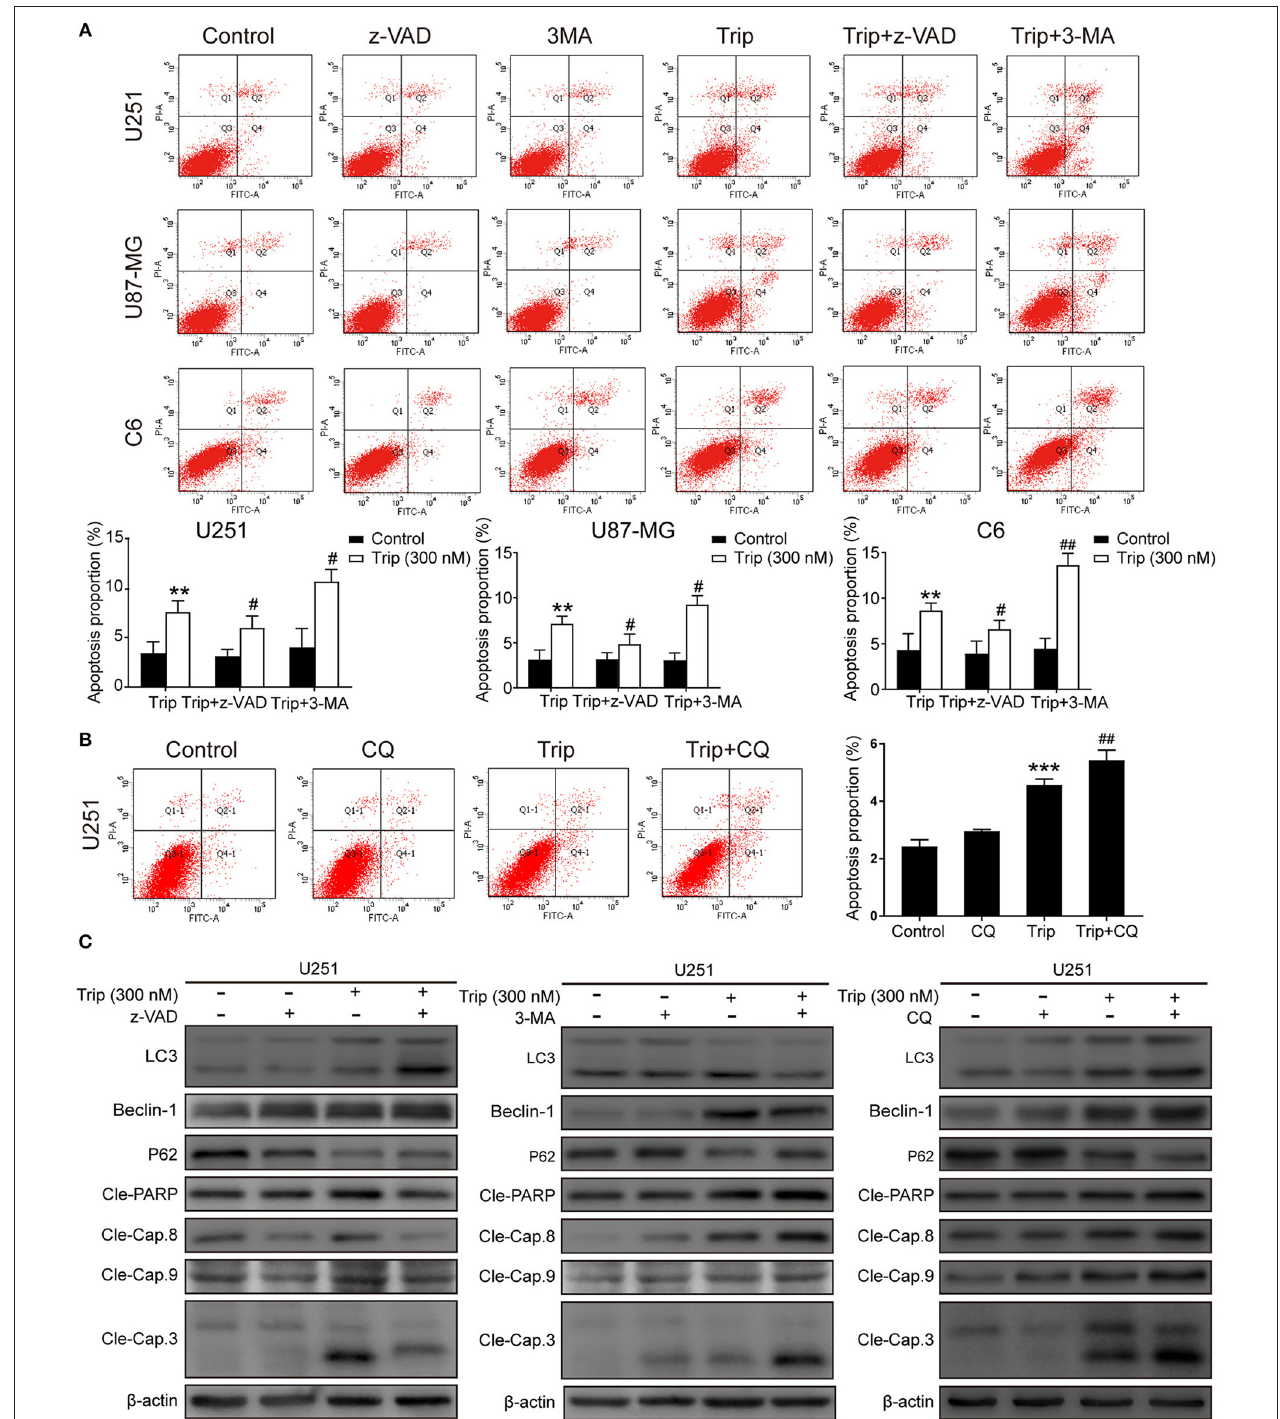
FIGURE 4 | Autophagy and apoptosis induced by triptolide can cross-inhibit each other. (A) U251, U87-MG, and C6 cells were pretreated with 3-MA or z-VAD for 2h, followed by treatment with triptolide (300nM) for an additional 24h. Apoptosis was analyzed by FACS using an Annexin V-FITC/PI cell apoptosis kit. Representative results from 3 independent experiments are presented. The data are presented as the means ± SD ( n = 3). ( B) U251 cells were pretreated with CQ for 2h, followed by treatment with triptolide (300nM) for an additional 24h. Apoptosis was analyzed by FACS using an Annexin V-FITC/PI cell apoptosis kit. (C) U251 cells were pretreated with 3-MA or z-VAD or CQ for 2h, followed by treatment with triptolide (300nM) for an additional 24h. Whole-cell lysates were separated by SDS-PAGE, and then, immunoblotting was performed using the indicated antibodies. ** P < 0.01, *** P < 0.001, significantly different compared with the untreated control group. # P < 0.05, ## P < 0.01, significantly different compared with the triptolide treatment group.